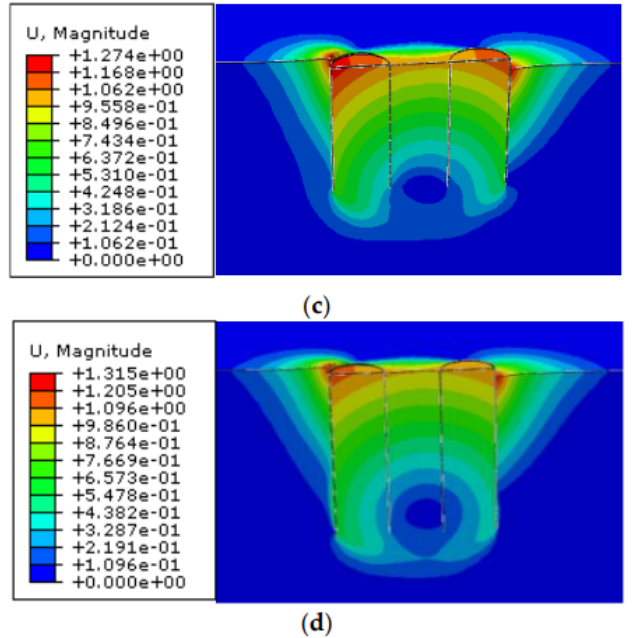
Figure 9. Displacement contours under horizontal loading: ( a ) L / D = 1 (single-barreled); ( b ) L / D = 1(four-barreled); ( c ) L / D = 2(four-barreled); ( d ) L / D = 3(four-barreled).